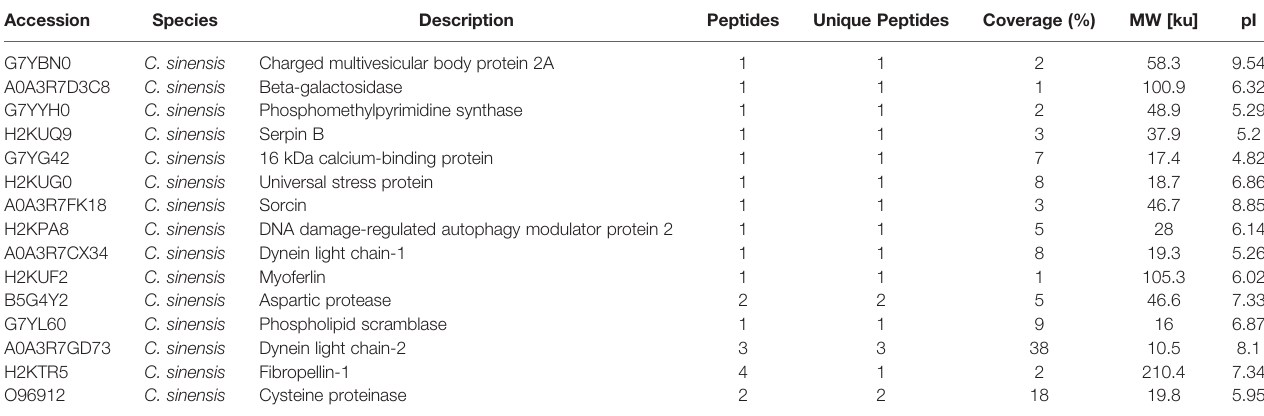
TABLE 4 | Clonorchis sinensis excretory and secretory products which were detected by sera of rabbits in 77 dpi.